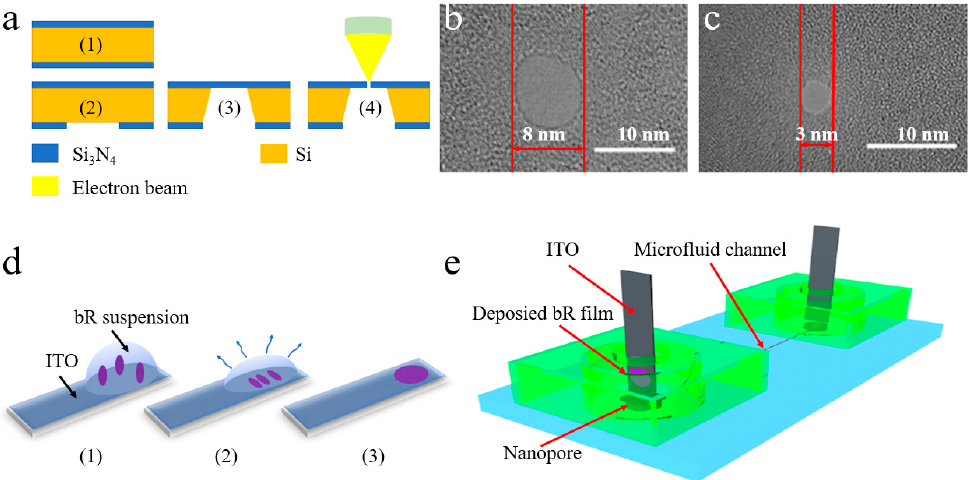
Figure 2. ( a ) Process flow of nanopore production. ( b ) TEM image of an 8 nm ‐ size nanopore. ( c ) TEM image of 3 nm ‐ size nanopore. ( d ) Process of evaporative deposition. ( e ) Complete device sche ‐ matic. The PDMS substrate contains a microfluidic channel (a semi ‐ cylinder with a height of 1.8